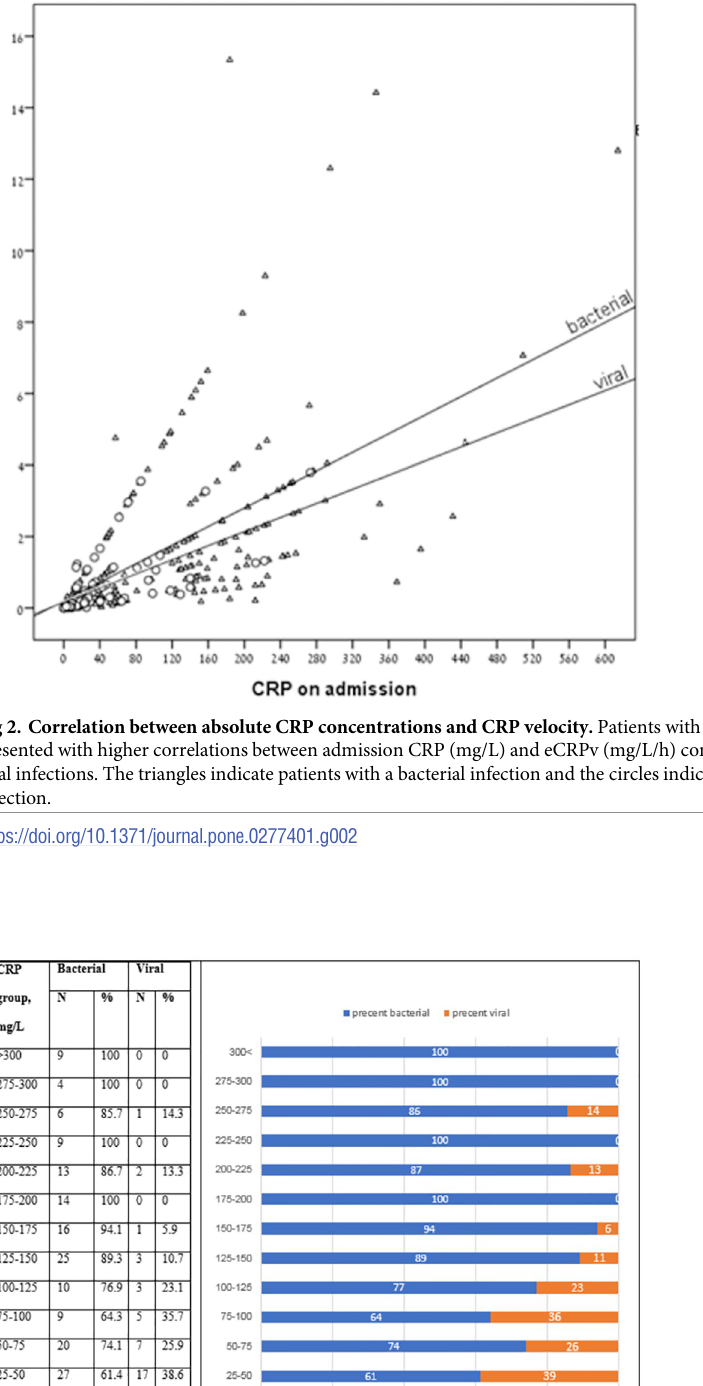
PLOS ONE | https://doi.org/10.1371/journal.pone.0277401 December7,